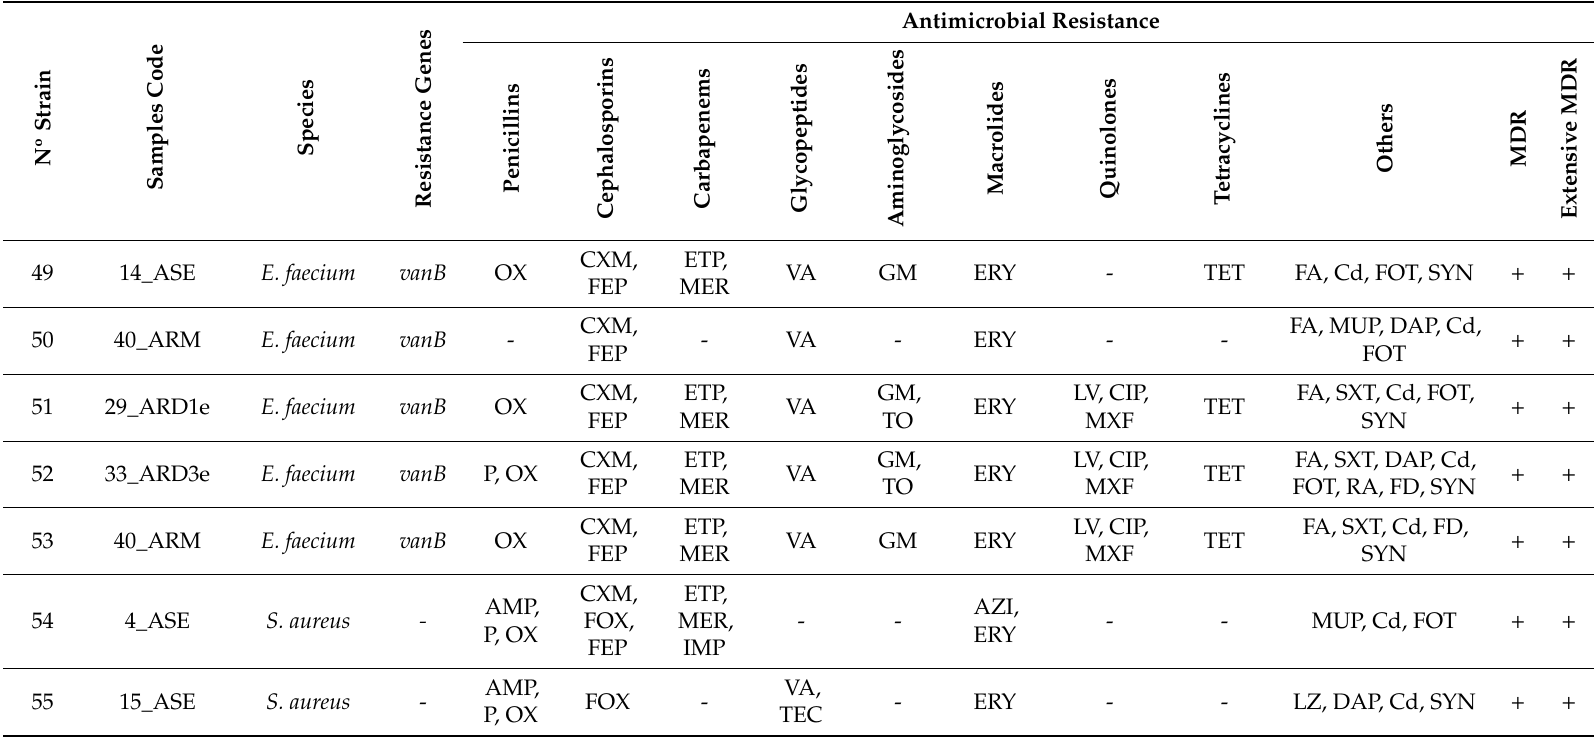
Table 6. Characteristics and antibiotic resistance profile of isolated Gram positive